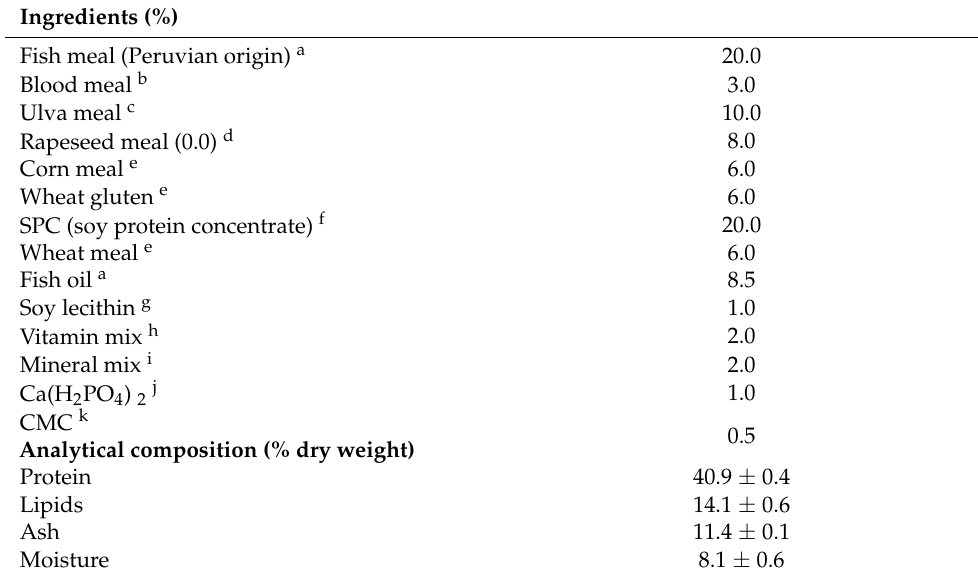
Table 1. Ingredients (g/100 g) and proximate composition of the diet used in the experiment. Ingredients